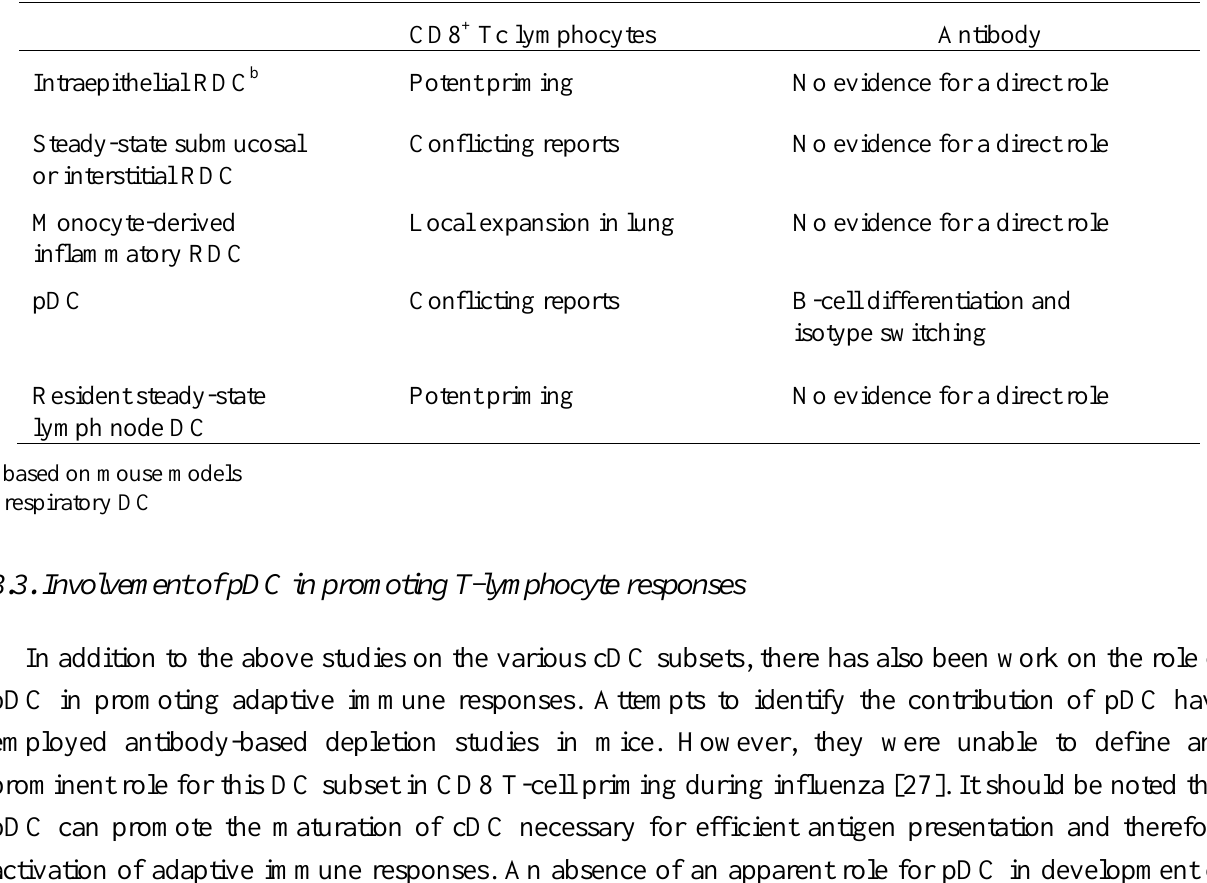
Table 2. Adaptive effector immune responses mediated by DC a